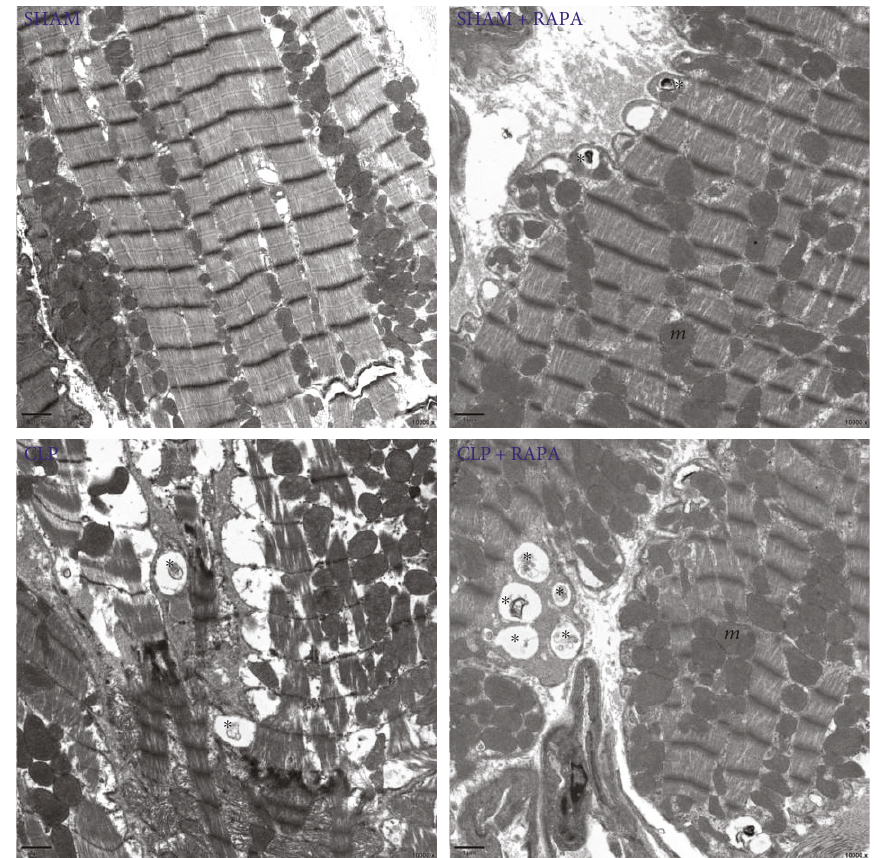
Figure 6: Ultrastructural features of autophagic vacuoles in the left ventricle harvested 18 h after CLP. The myocardium was normal in appearance with a proper mitochondria distribution in sham-operated rats. Myo fi brillar disarray was seen in CLP rats. There were more autophagic vacuoles (asterisk) in CLP+RAPA rats compared with CLP rats. Mitochondria ( m ) were seen throughout the cytoplasm. Magni fi cation ×